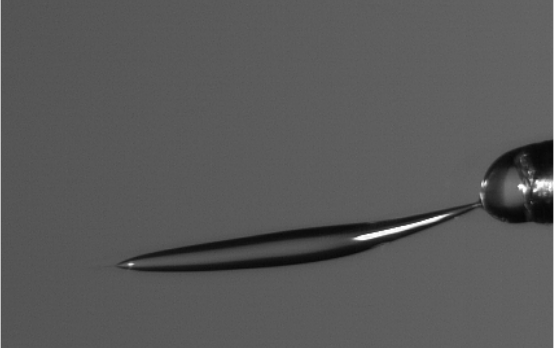
Figure 30. A spindle-like formation before the detachment from the mother droplet. The jet emanating from a tip of the spindle is visible on the left. The experiment was done in setup II with solution a0 at 22.0 ◦ C and relative humidity 40%. Photographs were exported from the record of the Olympus i-SPEED 720 high-speed camera using i-SPEED Software Suite